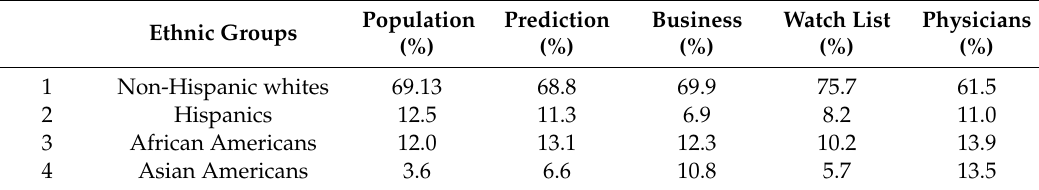
Table 4. Racial distribution of each ethnic group in